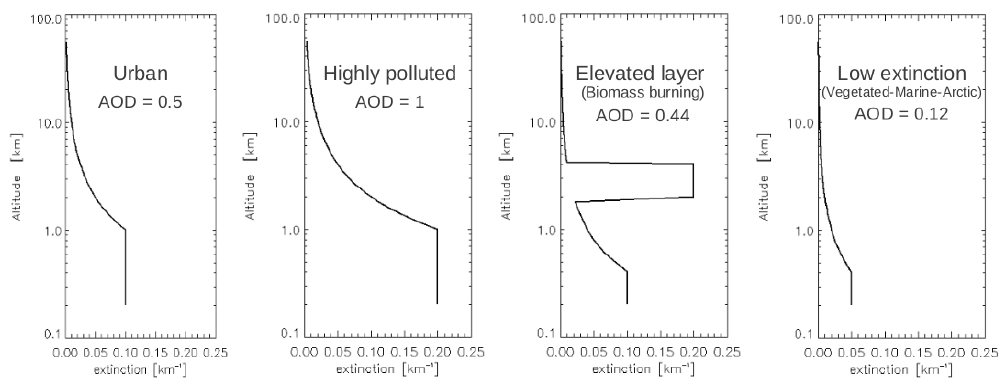
Figure 1. The four different aerosol profiles used in this study. From the left: urban ( k ext = 0.1km − 1 , BLH = 1km, AOD = 0.5), highly polluted ( k ext = 0.2km − 1 , BLH = 1km, AOD = 1), elevated layer ( k ext = 0.2km − 1 , altitude range = 2–4km, AOD = 0.44), low extinction ( k ext = 0.05km − 1 , BLH = 0.4km, AOD =